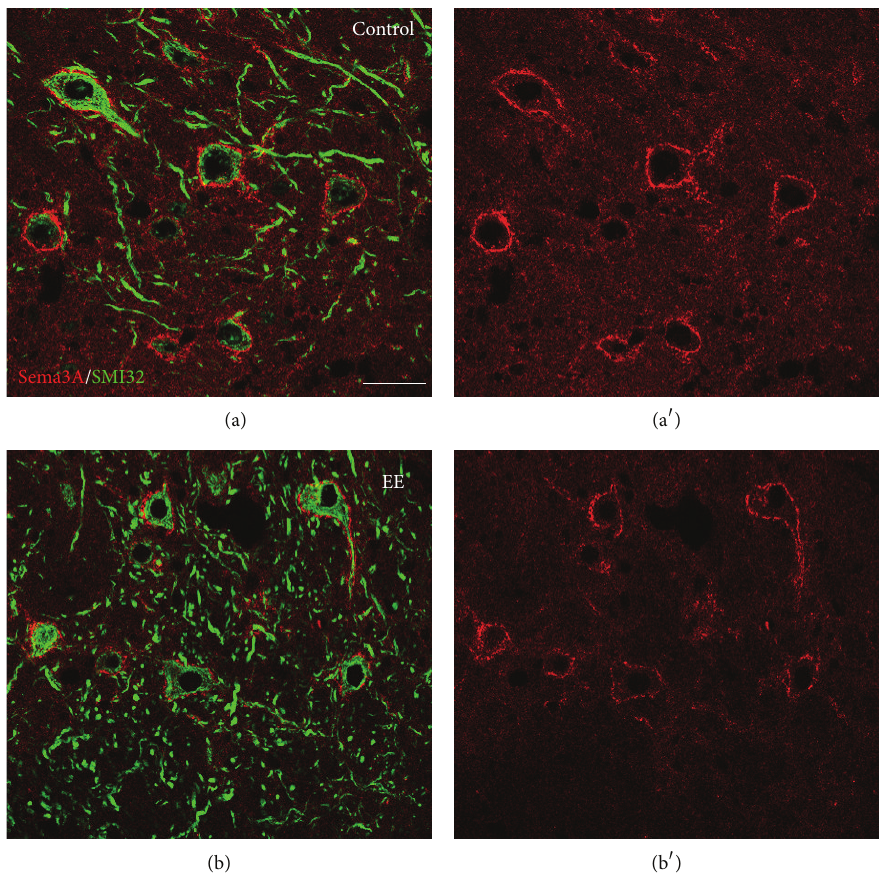
Figure 5: Exposure to enriched environment induces a reduction of Sema3A in the cerebellar nuclei of the adult mouse. (a)–(b 󸀠 ) show Sema3A immunostaining (red) around projection neurons of the cerebellar nuclei (stained by SMI32, green) of control mice (a, a 󸀠 ) and mice exposed to enriched environment (b, b 󸀠 ). A clear reduction of Sema3A levels is observed in enriched animals. EE: enriched environment. Scale bar: 50 𝜇